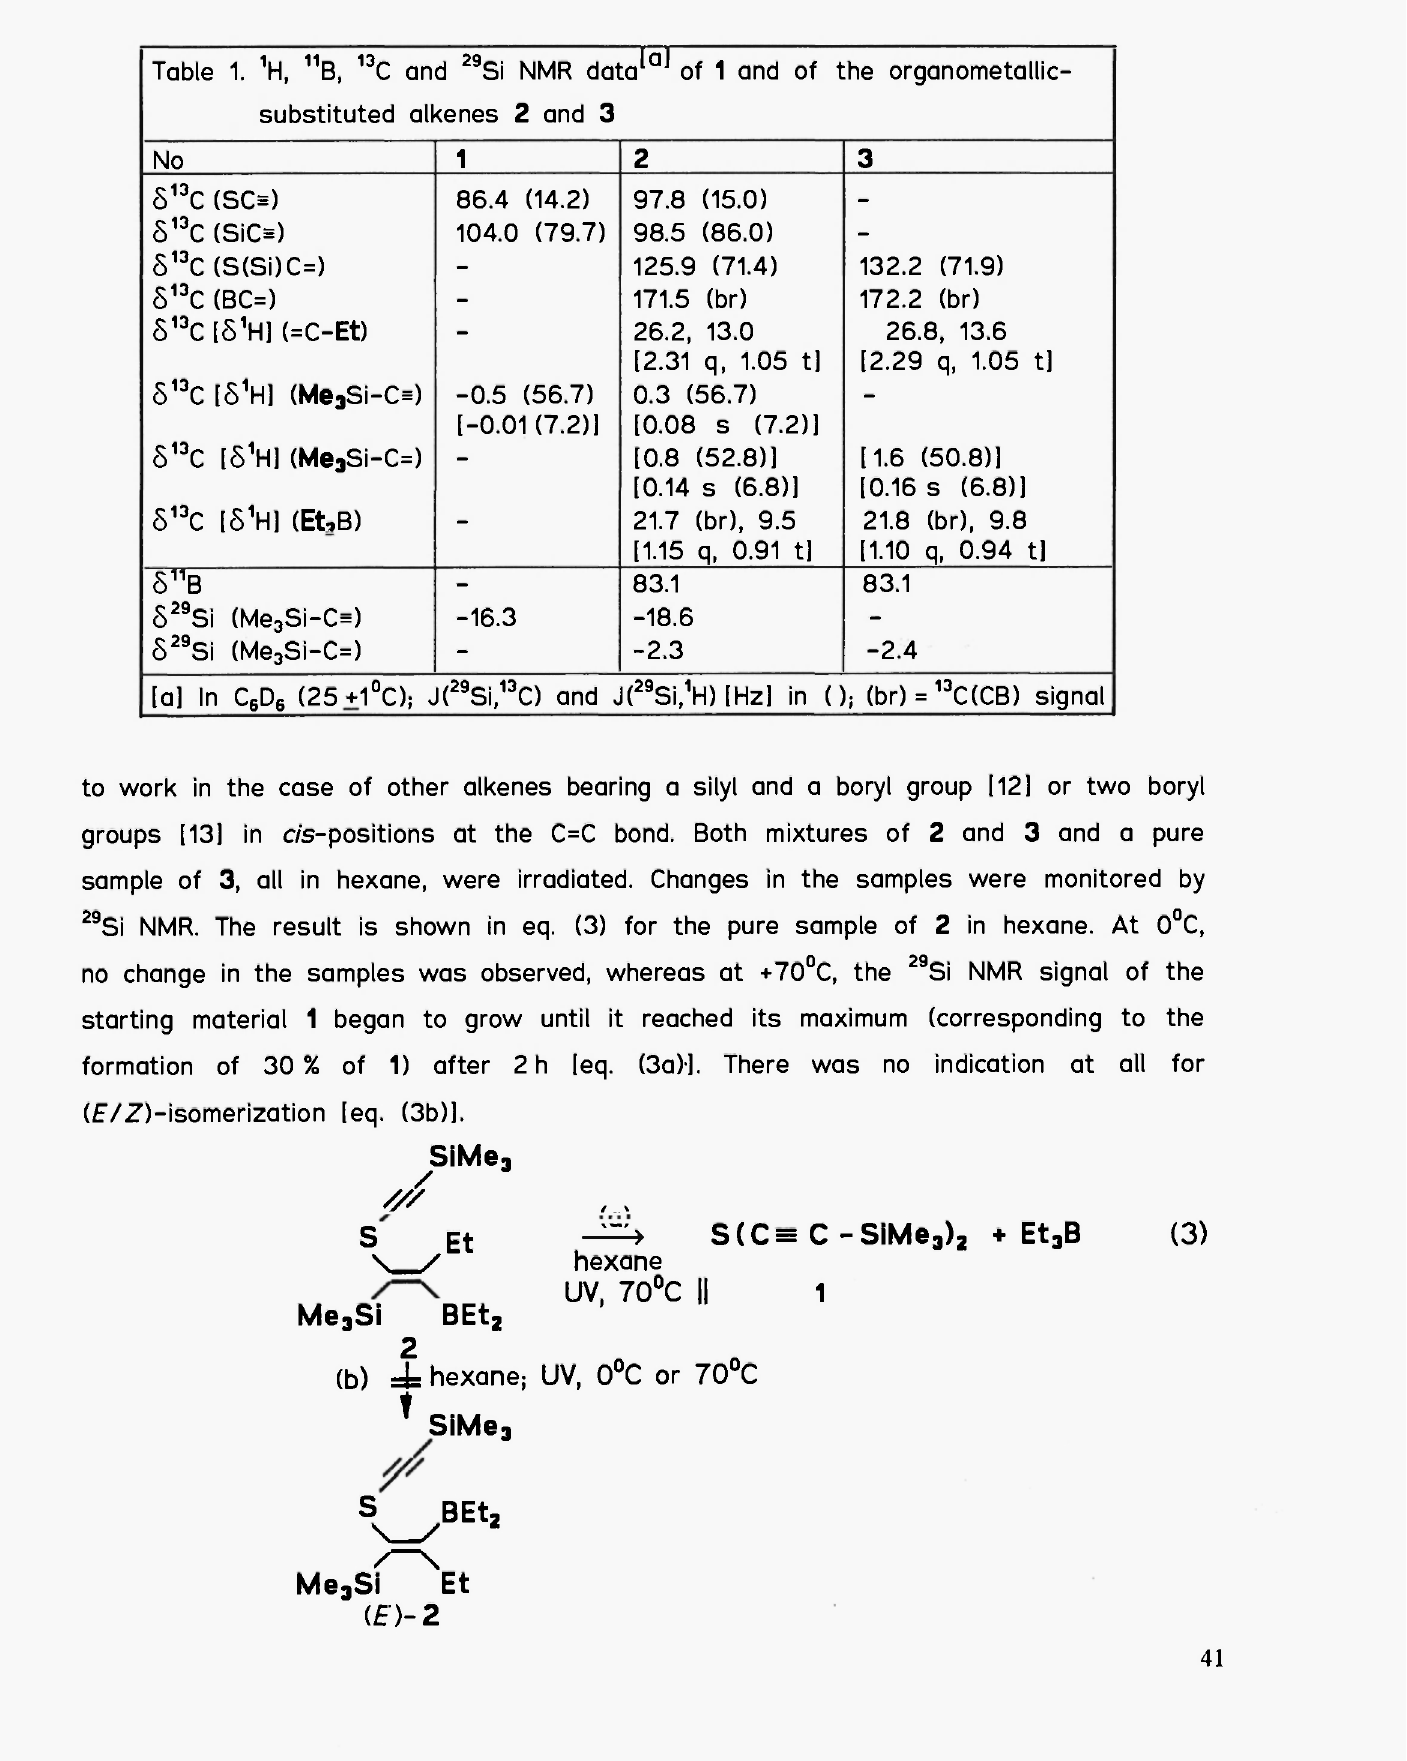
Table 1. 1 H, 11 B, 13 C and 29 Si NMR data |aJ of 1 and of the